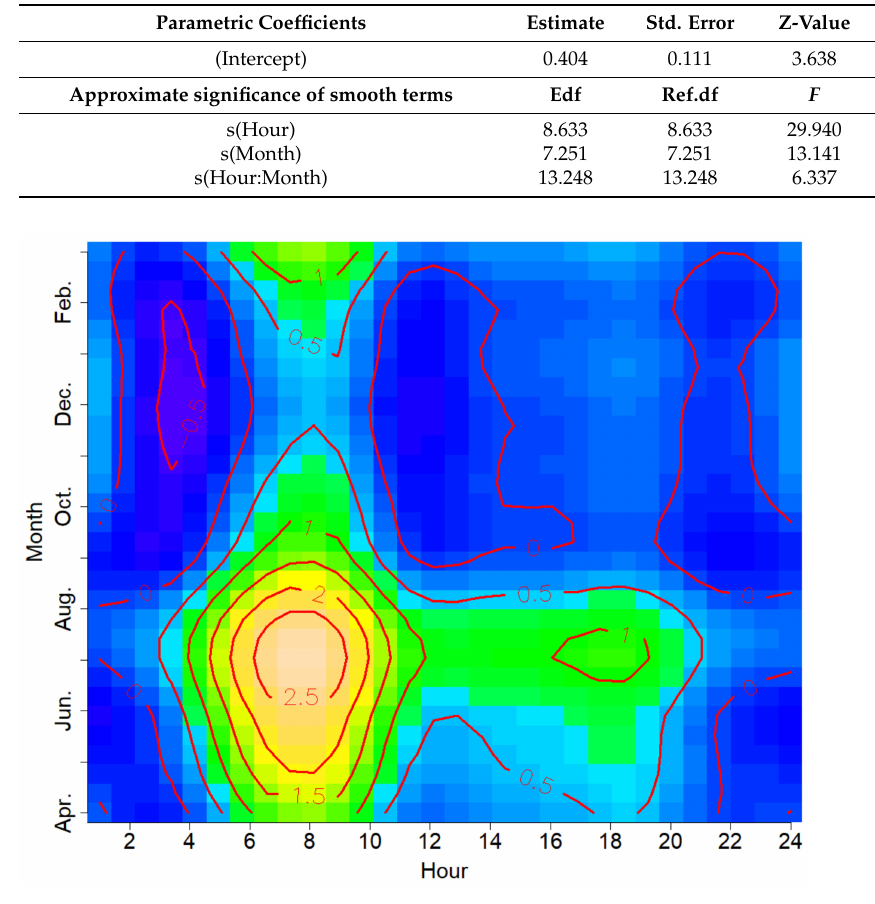
Figure 3. Combined seasonal and daily patterns of vocal activity in the Oriental Turtle Dove as the five-day average number of individual calls per hour in the annual cycle 2019–2020. The Oriental Turtle Dove’s vocal activity was more frequent from April to August (Figures 3 and 4), and the activity intensity was the strongest in July (Table S2). Our results indicated no vocal activity from November to